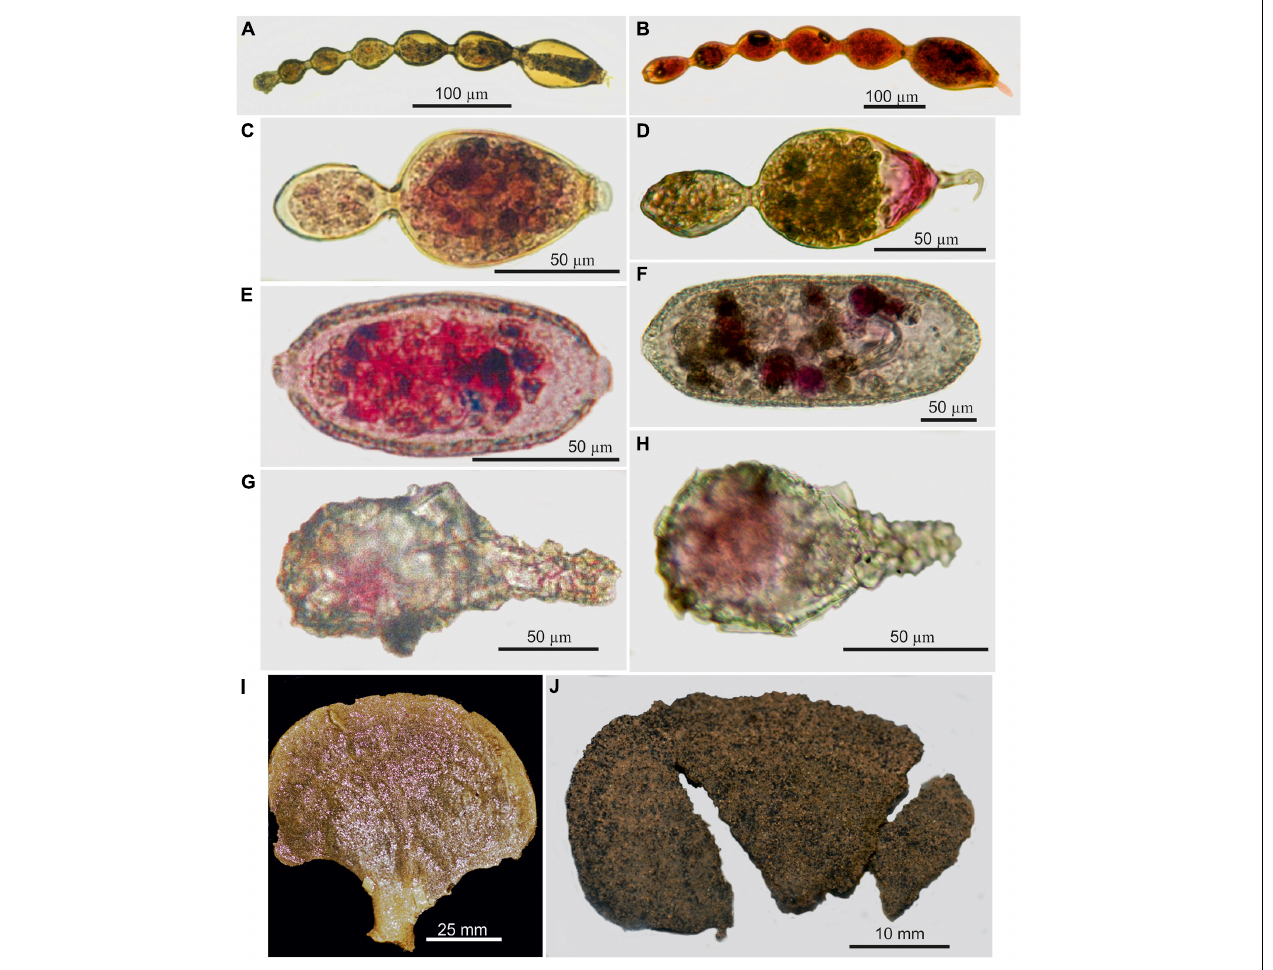
FIGURE 7 | Morphospecies occurring at the western (A,C,E,G,I) and eastern (B,D,F,H,J) ends of the CCZ. (A,B) Resigella moniliforme (Resig, 1982) from the JET site (A) and UK-1 contract area (B) . (C,D) Bilocular Resigella sp. from the JET (C) and KE (D) sites. (E,F) Saccamminid with terminal apertures from the JET site (E) and UK-1 contract area (F) . (G,H) Lagenammina sp. from the JET site (G) and OMS contract area. (H) Moanammina semicircularis Gooday and Holzmann, 2020 in Gooday et al. (2020a) from APEI4 (I) and the OMS contract area (J) ; in this case, genetic data confirm that these two specimens are conspecific (Gooday et al.,